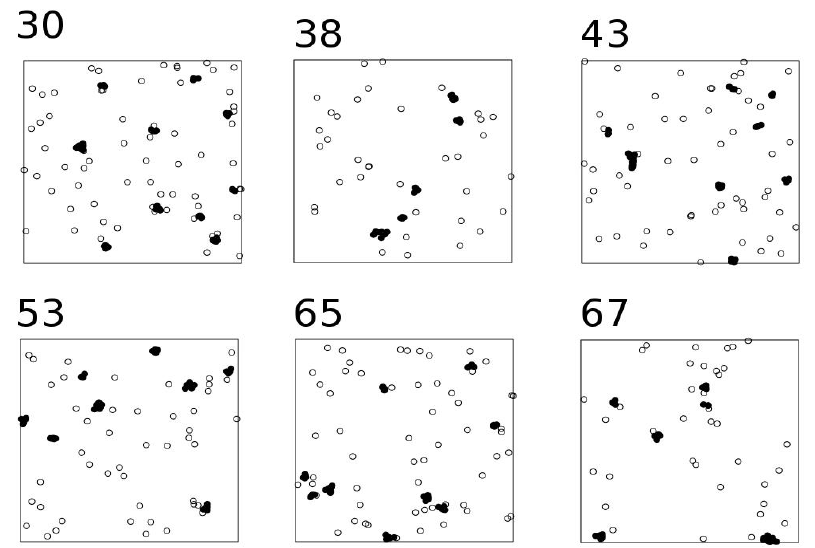
Figure 2. Examples of NNIC using random points. Open circles are non-clustered points; black circles are clustered points. Figure numbers indicate the number of the iteration (see Table S1). Table 1. Summary results for the virtual example. Mean, standard deviation, minimum, and maximum number of random points, number of clustered points identified by NNIC, number of clusters identified by NNIC, and number of clustered points identified by NNC. NNIC: nearest neighbour index clustering. NNC: nearest neighbour cleaning.